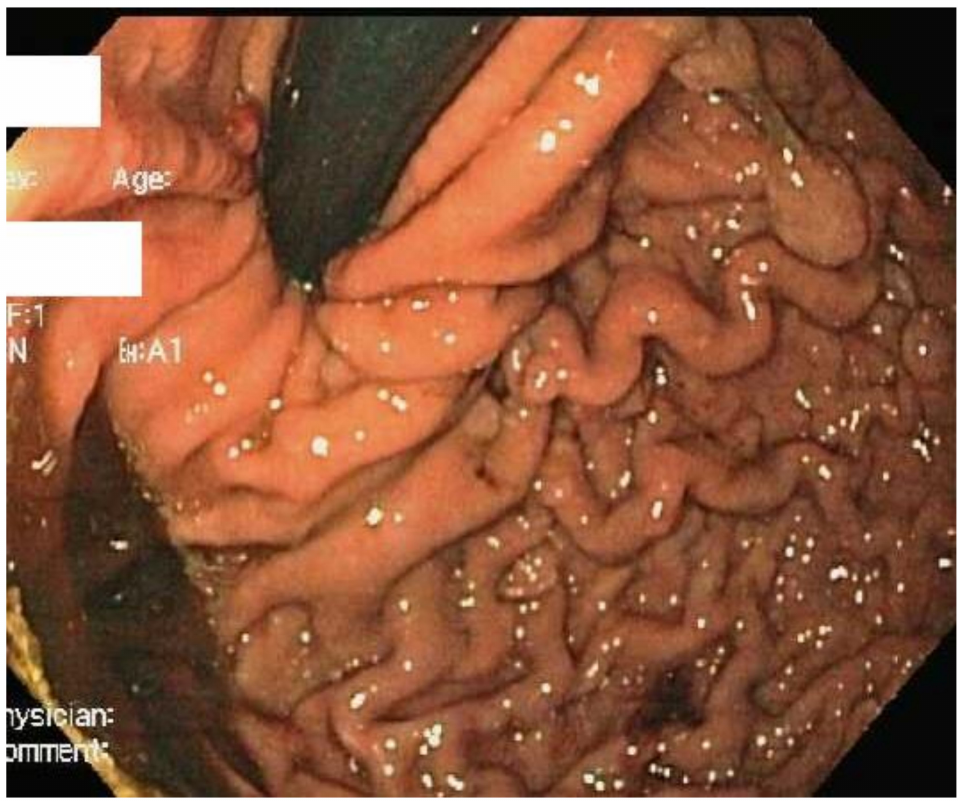
Figure 2. Intraoperative image showing endoscopic retroflexion view of the Dor